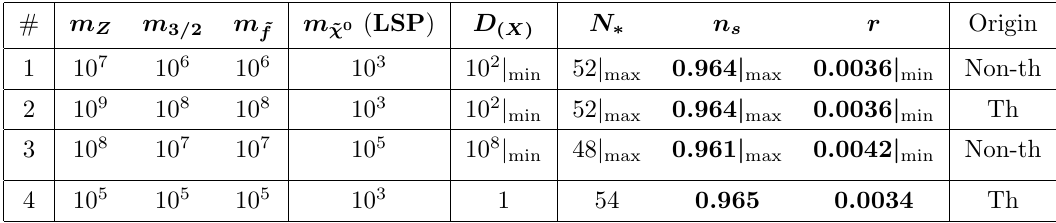
Table 2 . The n s and r prediction for neutralino LSP and anomaly/gravity mediation scheme for the R 2 supergravity model. In the case # 1 the neutralino annihilate after the decay of gravitinos, while in case # 2 neutralinos acquire a thermal abundance. In the case # 3 the neutralinos from the gravitino decay are overabundant and a diluter X is required. The case # 4 is the standard thermal WIMP scenario. The masses are in GeV